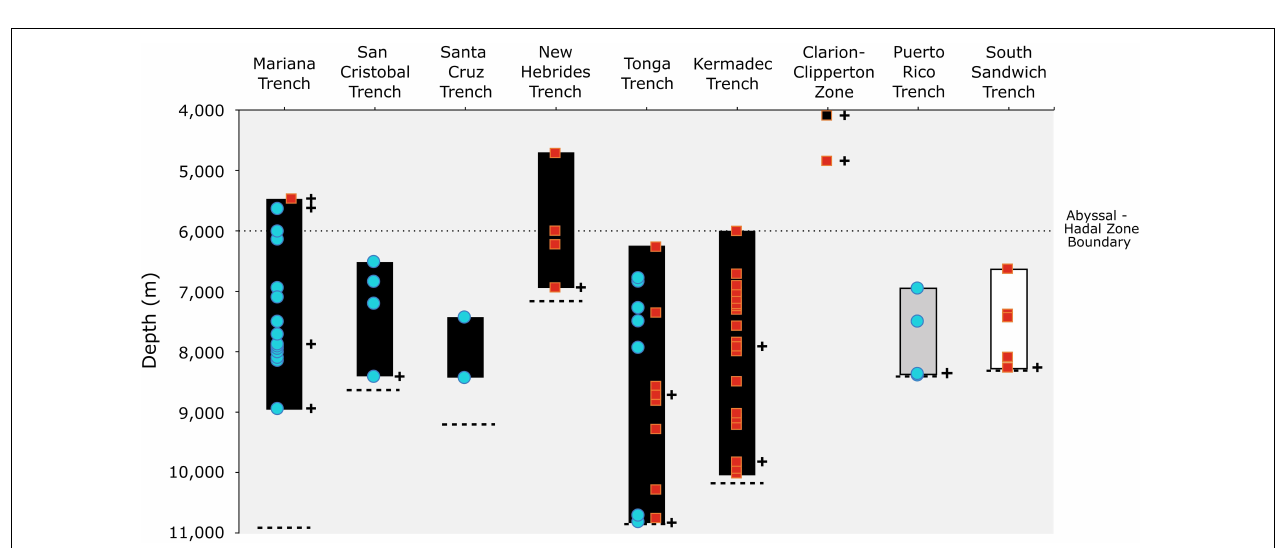
FIGURE 2 | Vertical distribution of the amphipod Hirondellea dubia (solid bar) across nine features in the Pacific (black), North Atlantic (gray), and Southern/South Atlantic (white) oceans with new records (blue circle) and historical records (red square). Cross symbols indicate records with corresponding molecular data, namely 16S and COI. The black square at the Clarion-Clipperton Zone represents the molecular record that was not delimited as H. dubia . The dashed lines represent the maximum trench depth (Stewart and Jamieson, 2018; Bongiovanni et al., 2021).